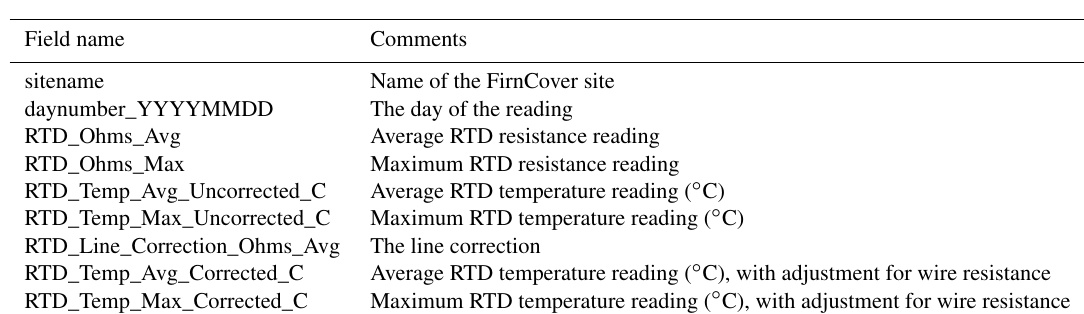
Table A4. Firn_Temp_Daily table.